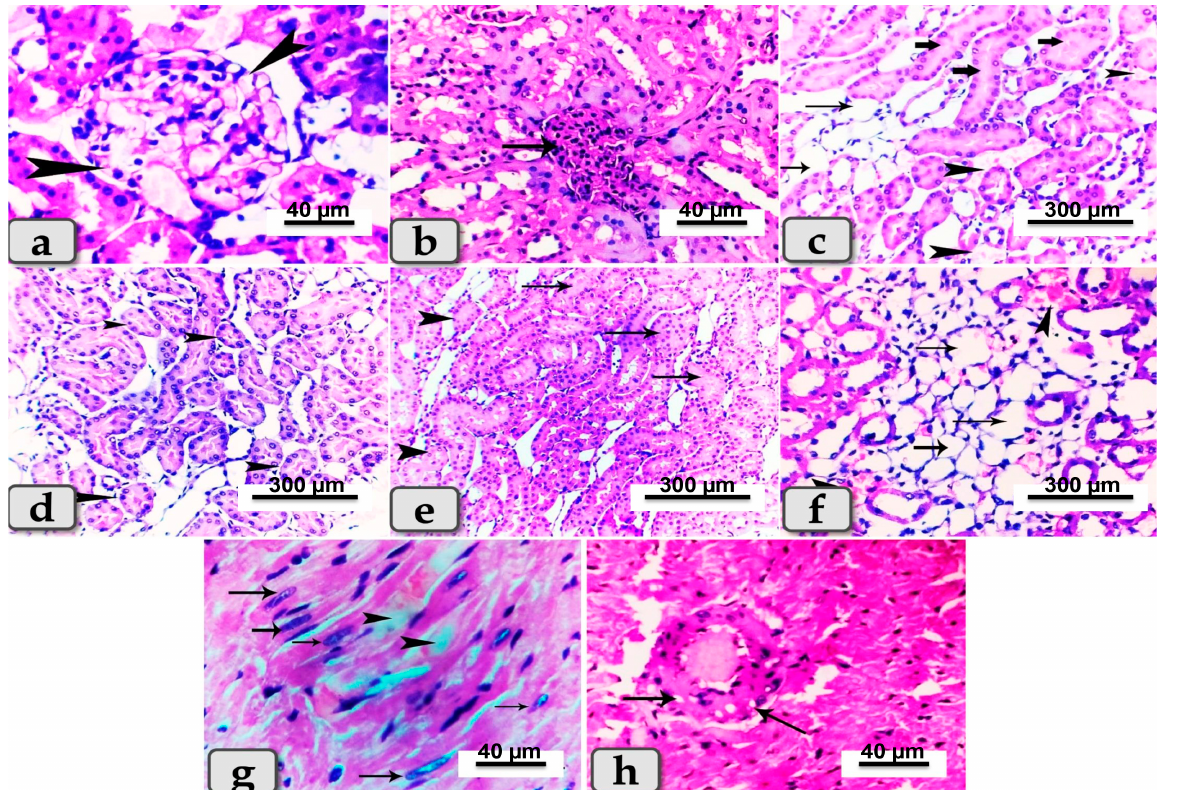
Figure 7. Photomicrographs of kidneys and hearts from rats su ff ering diabetes and treated with BV (Group 4). ( a ) Showing renal glomerulonephritis (arrow heads). ( b ) Showing hyper-cellularity of renal glomeruli (arrow). ( c ) Showing di ff use congestion of blood vessels (arrow head) with cystic dilation of some renal tubules (thin arrows) and cloudy swelling of others (thick arrow). ( d ) Showing atrophy of some renal tubules within renal medulla (arrow head). ( e ) Showing cloudy swelling of some renal tubules (arrows) and atrophy of others (arrow head). ( f ) Showing di ff use inter- and intra-tubular hemorrhage and congestion of blood vessels (arrow head) with cystic dilation of some renal tubules (arrows). ( g ) Photomicrograph of cardiac muscle showing degeneration of some cardiomyocytes (arrow head) and proliferation of Anitschkow cells (arrows). ( h ) Showing vacuolations of the vascular wall (arrows). Stain: All H&E. Sacri fi ced rats of Group (5) su ff ering diabetes and treated with both SeNPs and BV